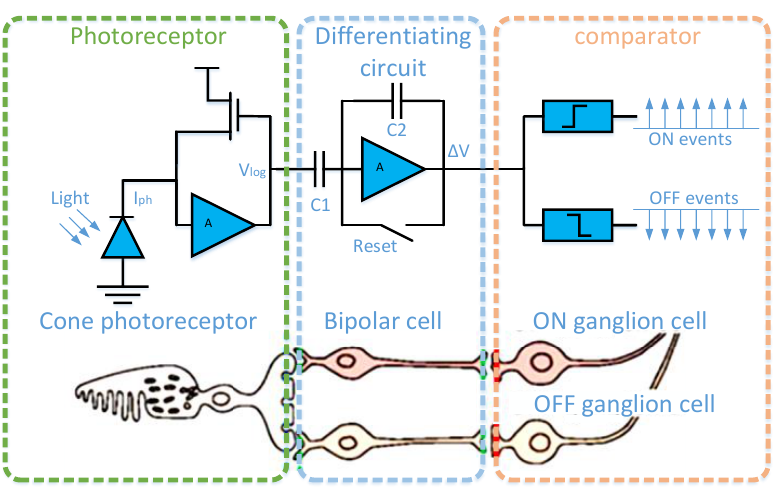
Figure 1. Three-layer model of a human retina and corresponding DVS pixel circuitry. The first layer is similar to retinal cone cells for photoelectric conversion; the second layer, similar to bipolar cells in the retina, is used to obtain changes in light intensity; the third layer is similar to the ganglion cells of the retina for outputting the light intensity change sign.